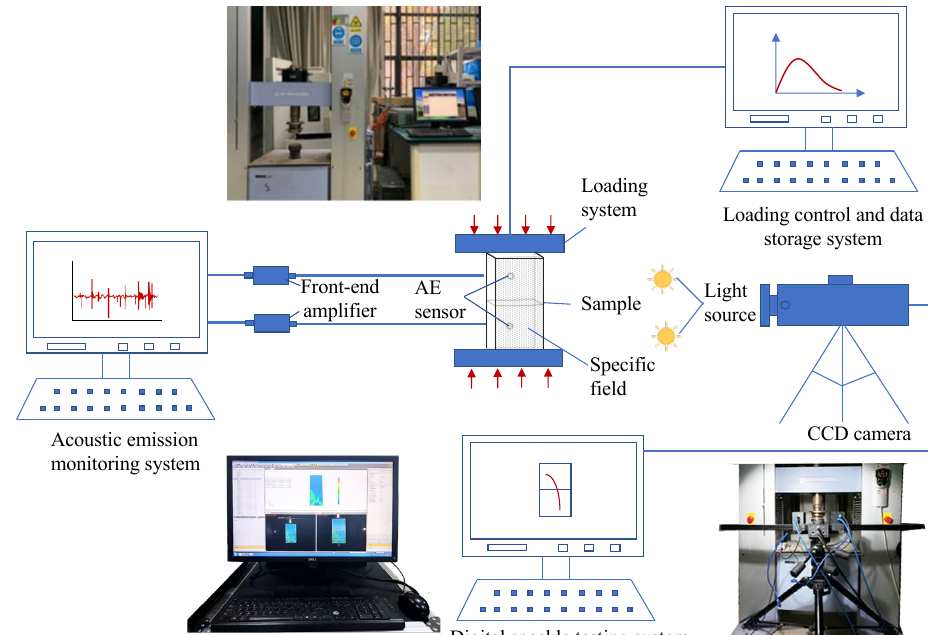
Figure 3. Testing equipment and system.